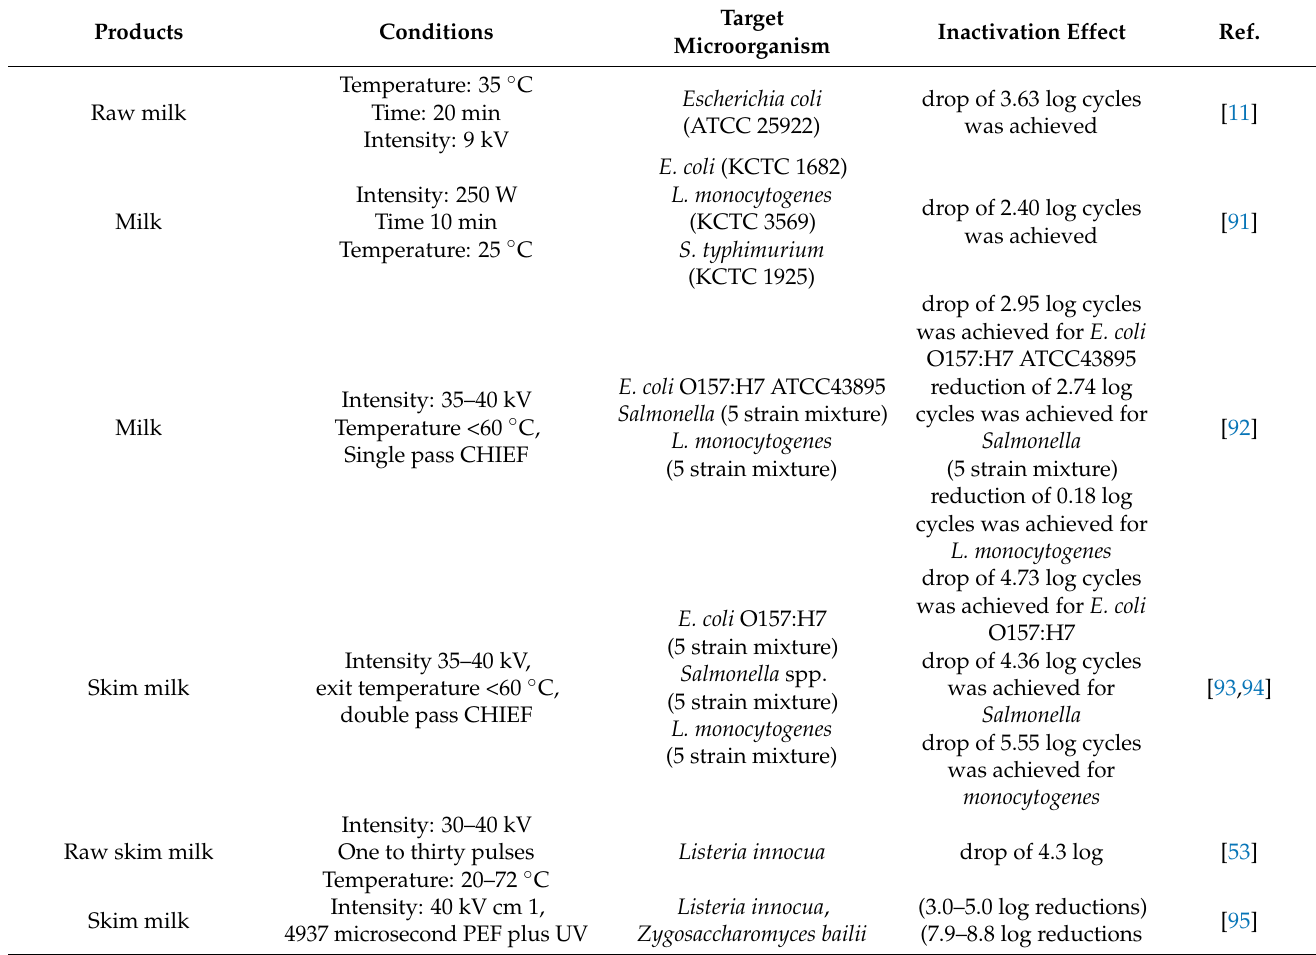
Table 5. Inactivation of microorganisms by cold plasma treatment in milk and milk products.